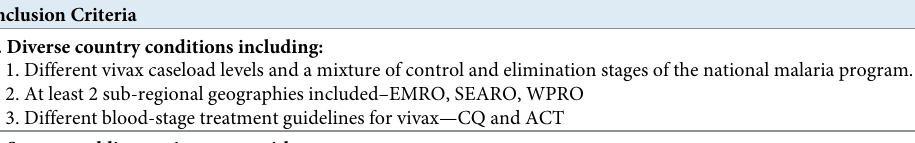
Table 2. NMP country selection